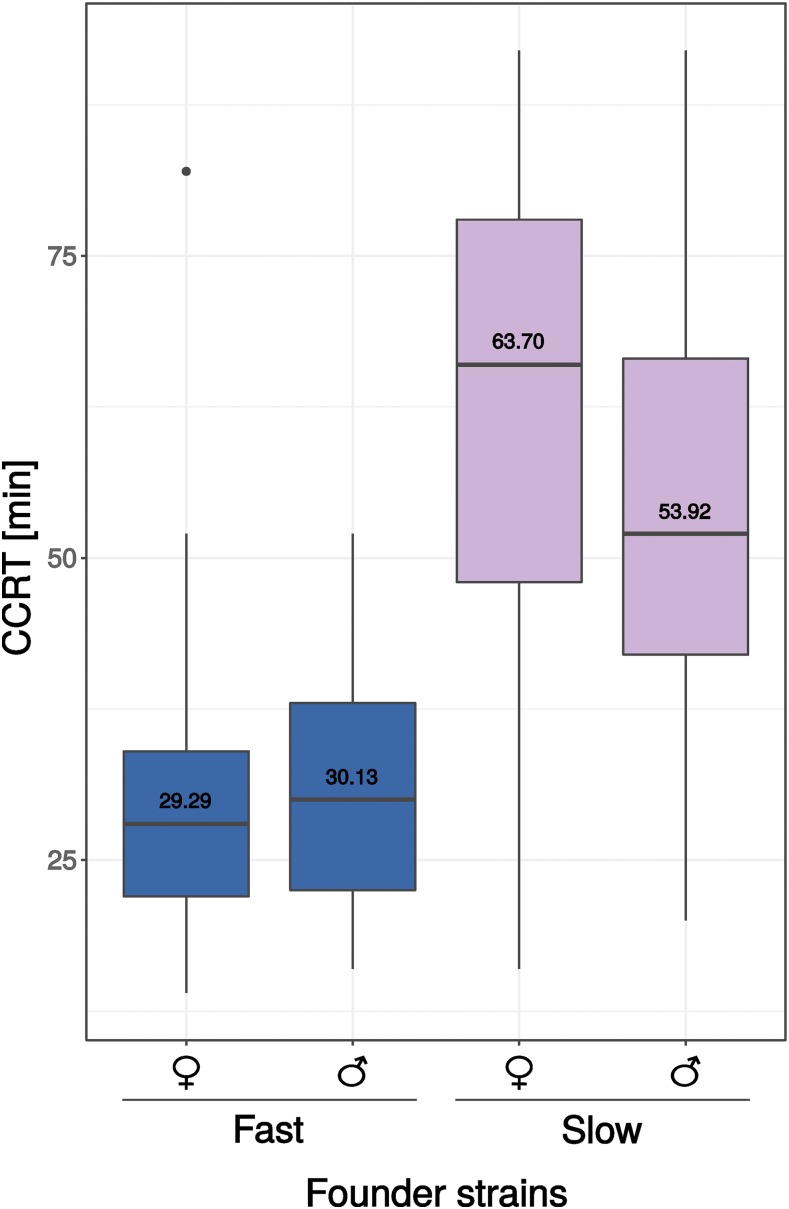
Chill coma recovery time (CCRT) of 4-6 day old flies of two strains of D. ananassae from Bangkok (Thailand) that were used as founder strains for the mapping population. The effect of the founder strain on CCRT was significant (Likelihood ratio test, P-value < 0.0001). The effect of sex on CCRT was not significant (Likelihood ratio test, P-value = 0.2522).